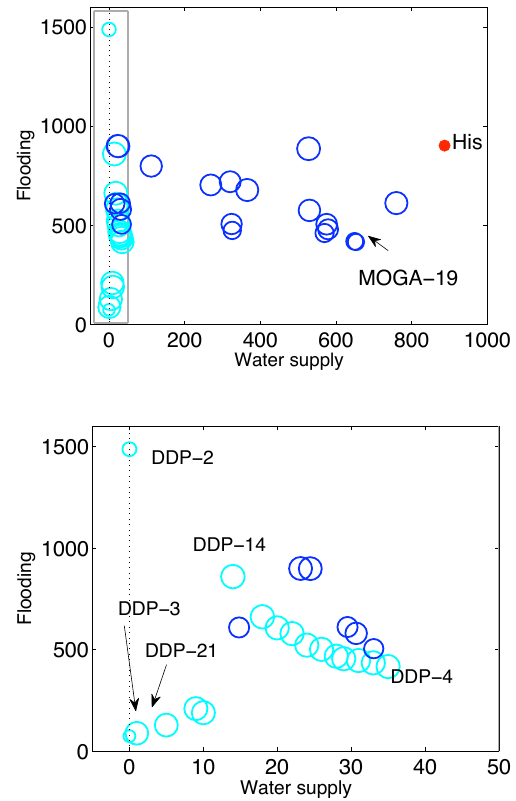
Fig. 4. Top panel: average value of the immediate costs over the horizon 1995–2004 under historical operation (red), operating poli- cies optimized by MOGA (blue) and by DDP (cyan). Bottom panel: zoom of the box in the top panel.